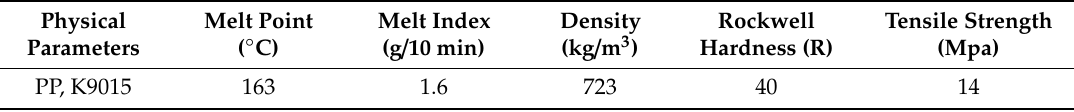
Table 1. Physical parameters of the polypropylene (PP,